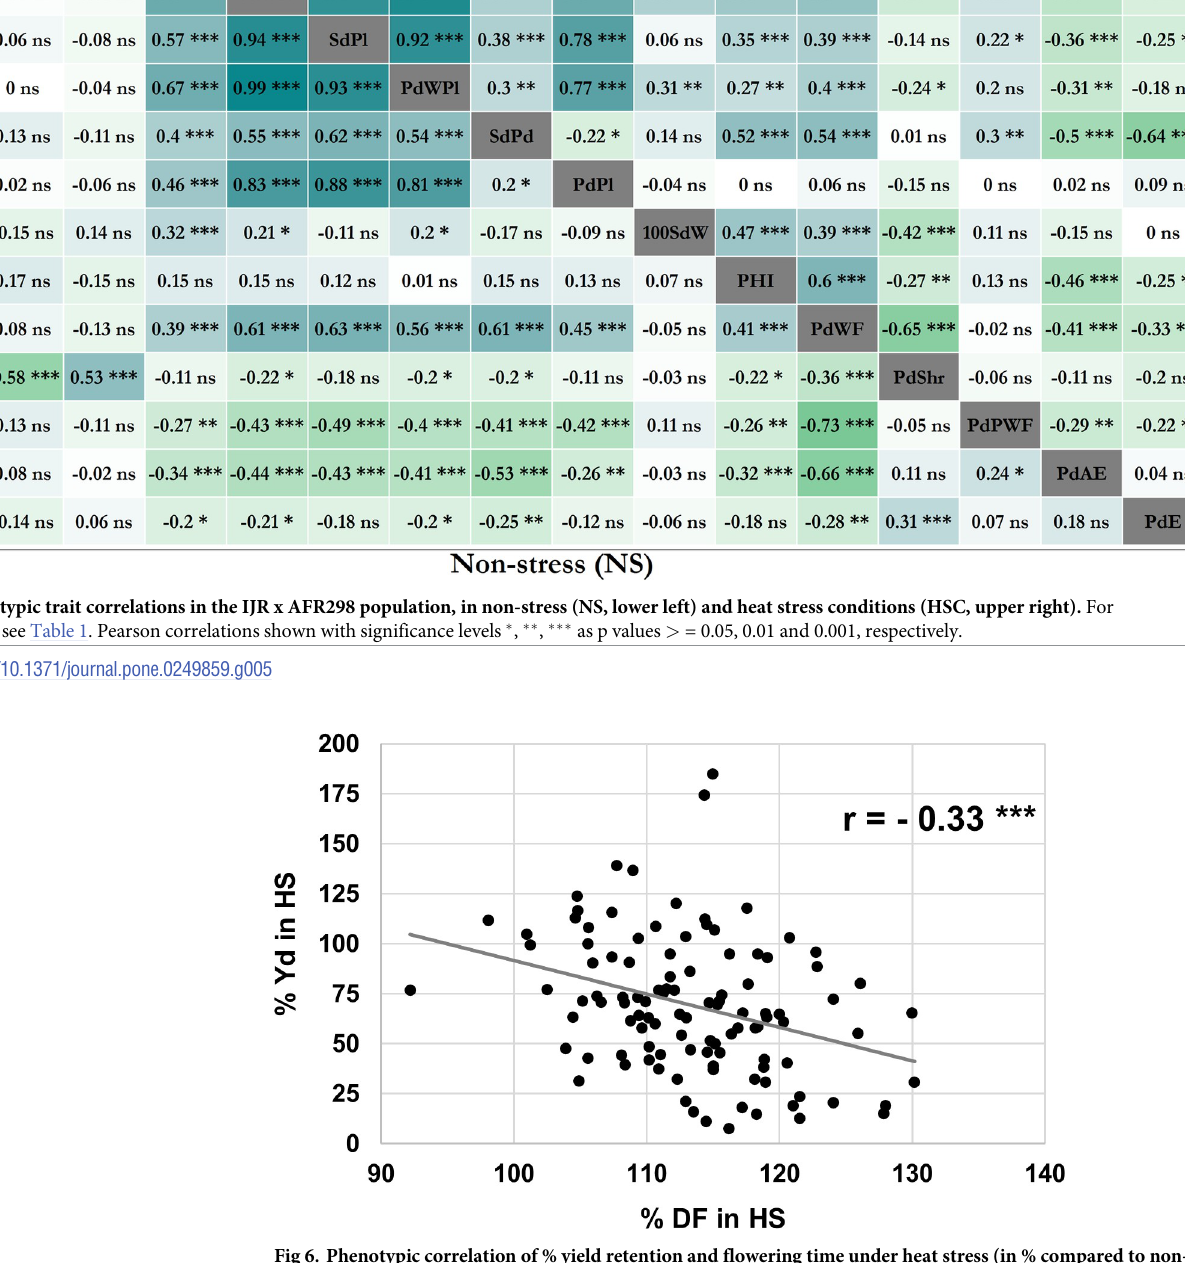
PLOS ONE | https://doi.org/10.1371/journal.pone.0249859 April 29, 2021 13 /